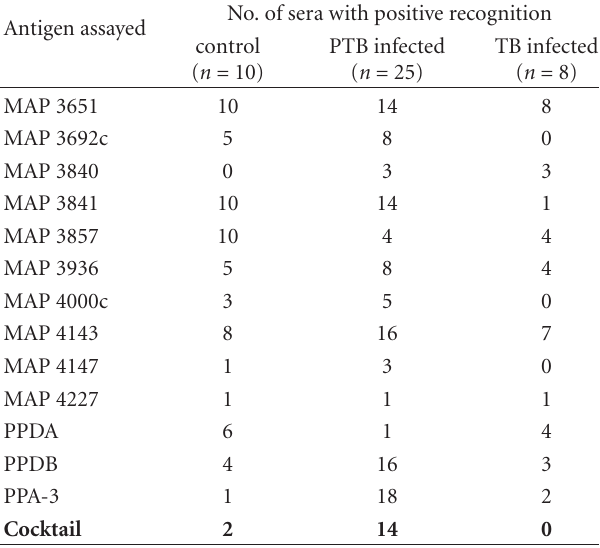
20uL of antigens were applied to a nitrocellulose membrane (Amersham Hybond-ECL, GE Healthcare Life Sciences, UK) at a concentration of 100ug/mL, using a semiautomatic aerolizer (Camag Scientific Inc., Wilm- ington, Delaware). Membranes were evaluated by immunoblotting using sera from healthy and infected animals. Numbers of sera with antibody response are indicated. Samples with intensities values higher than the media obtained with the control (PBS) were considered positive. Antigens selected to evaluate as cocktail are shown in bold. PPA-3: Paratuberculosis protoplasmaticantigen (Allied Monitor, Inc. USA); PPDA and PPDB: avian- and bovine-derivative protein purified (Prionic Switzerland ); Cocktail: Mix of the 7 antigens shown in